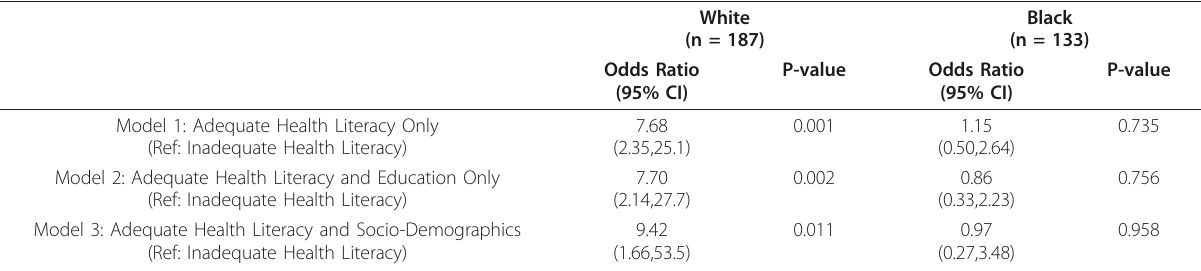
Table 3 Sequentially-Built Logistic Models of CAM use by racial